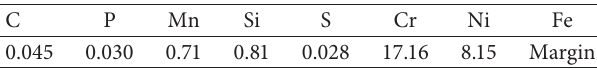
Table 1: 304 main chemical composition of stainless steel (per- centage by weight).